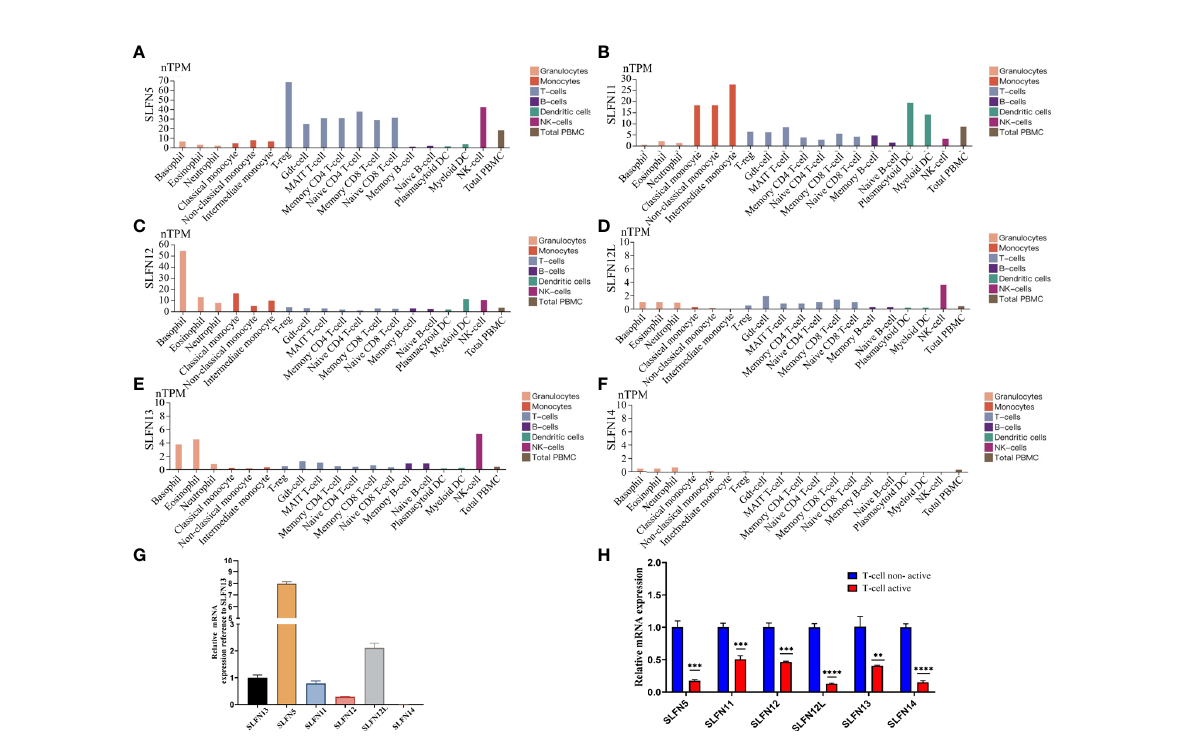
FIGURE 8 Expression of SLFN family in PBMC. (A) SLFN5 was highly expressed in Treg cells, NK cells, naive CD4 T cells, and naive CD8 T cells. (B) SLFN11 was highly expressed in monocytes and dendritic cells. (C) SLFN12 was highly expressed in basophils and monocytes. (D) SLFN12L was highly expressed in NK cells. (E) was highly expressed in eosinophils, basophils, and NK cells. (F) SLFN14 had generally low expression. (G, H) SLFN family mRNA expression was down-regulated after active of T cells. (G) In PBMC, compared with SLFN13, the expression level of SLFN5 was the highest, followed by SLFN12L, and the expression level of SLFN13 was the third. Compared with other families, the expression level of SLFN14 was negligible. (H) Changes of SLFN family mRNA expression before and after T cell activation. **p < 0.01 and ***p <